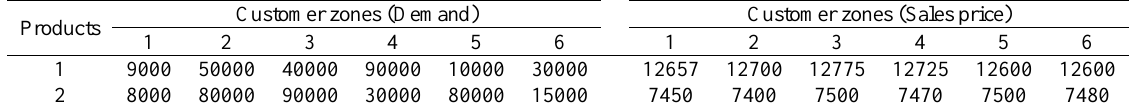
Table 2. Demand of customer zones and sales price